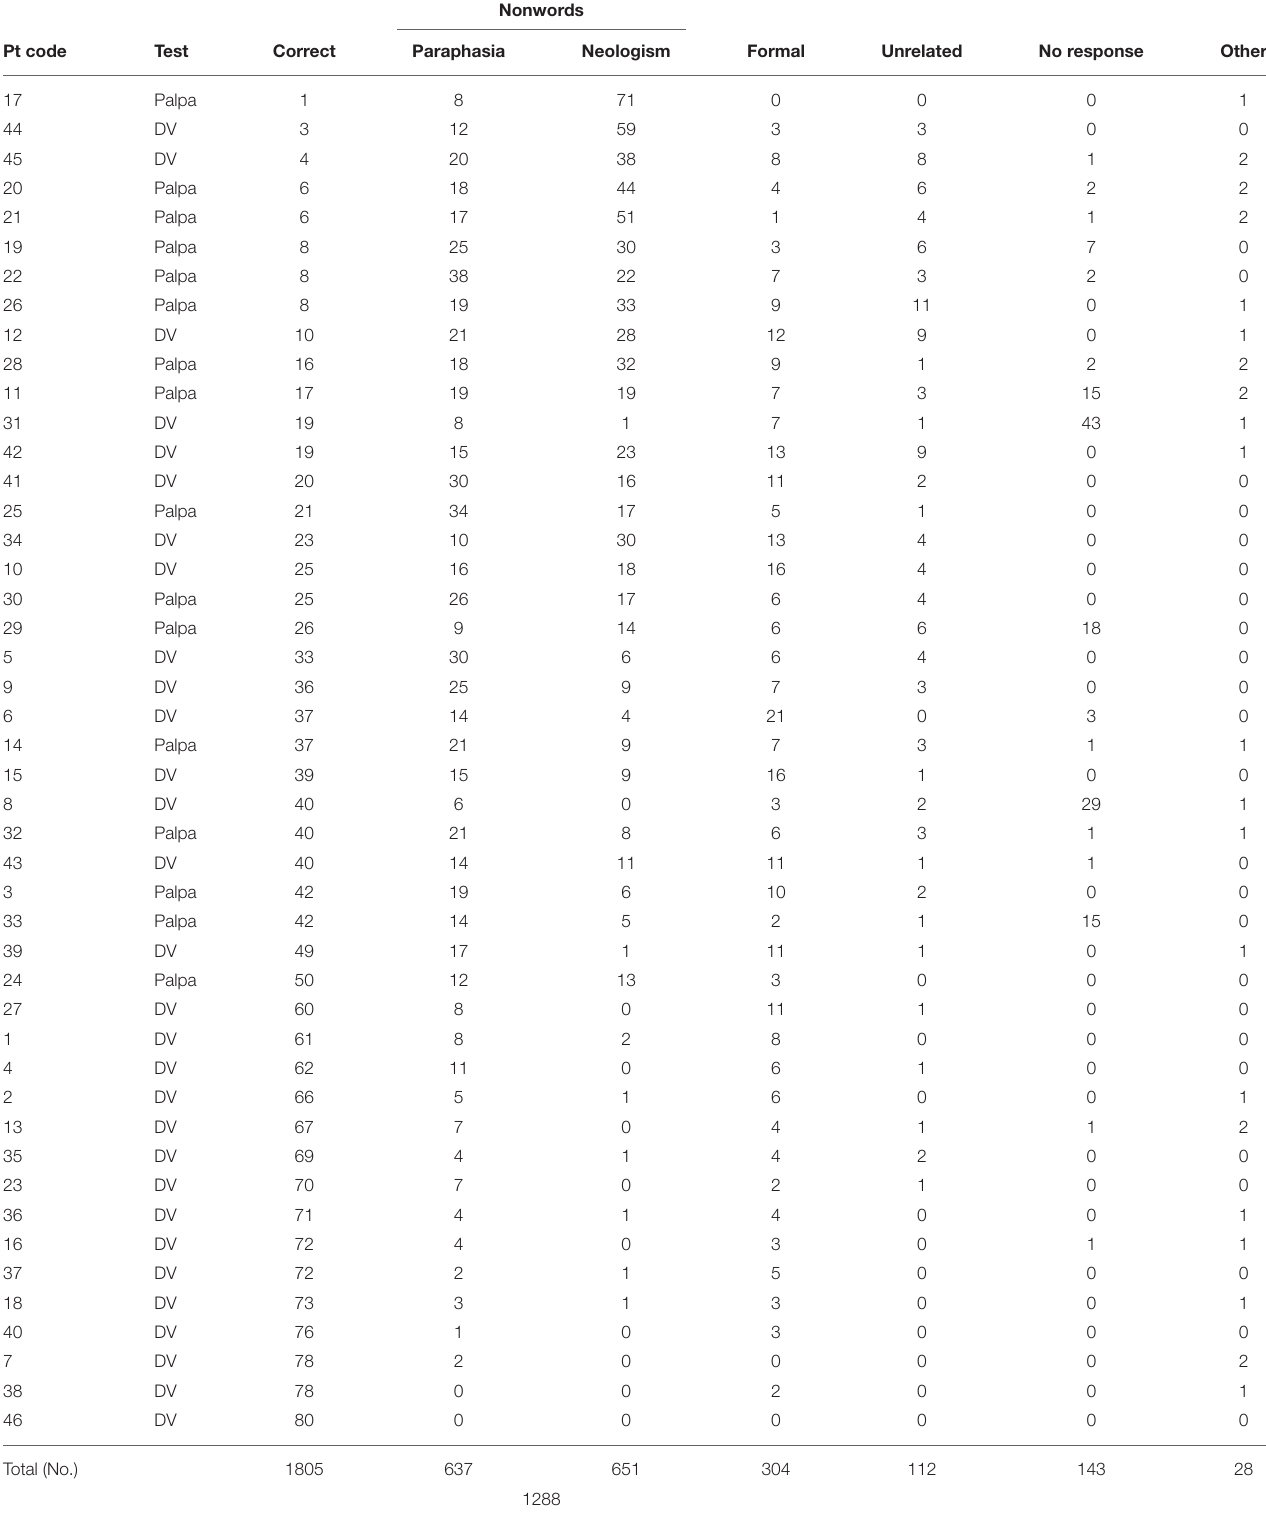
TABLE 2 | Number of each response type on single word repetition